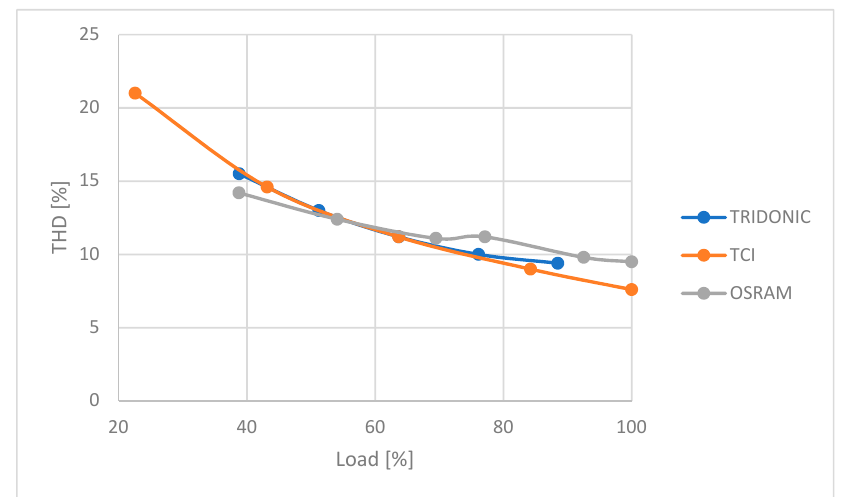
Figure 12. Influence of PSU load on THD .